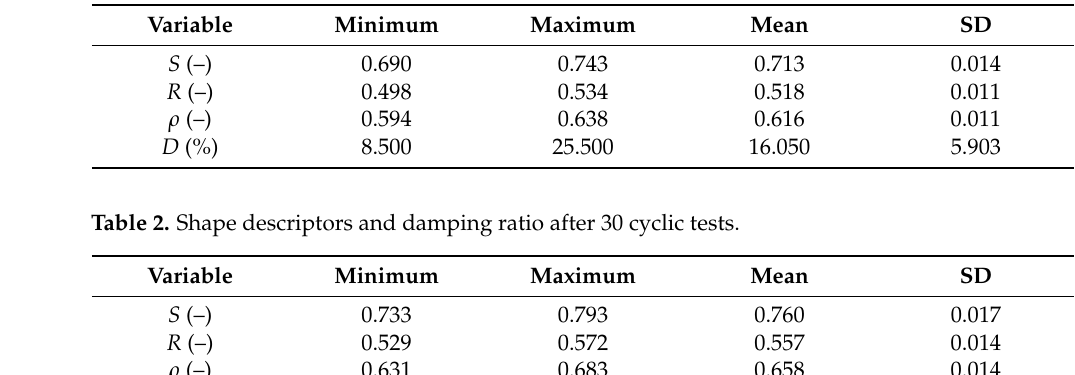
Table 1. Shape descriptors and damping ratio before cycling.